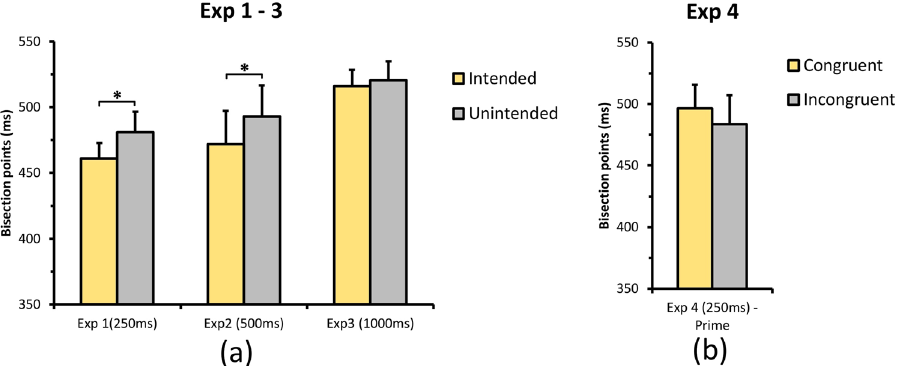
Figure 5. Results of four psychophysical experiments. ( a ) Represents the bar graph of BP (bisection point) for Experiments 1, 2 & 3, and ( b ) represents the bar graph of BP for two conditions in Experiment 4, where the prime (word) congruent or incongruent event appeared 250 ms after the key press. Error bar represents Standard Error (S.E.) and * indicates p <